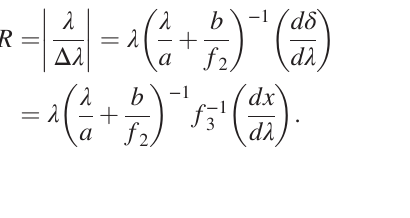
where dx=d λ denotes the linear dispersion of the spec- trometer (in units of [mm = nm]).